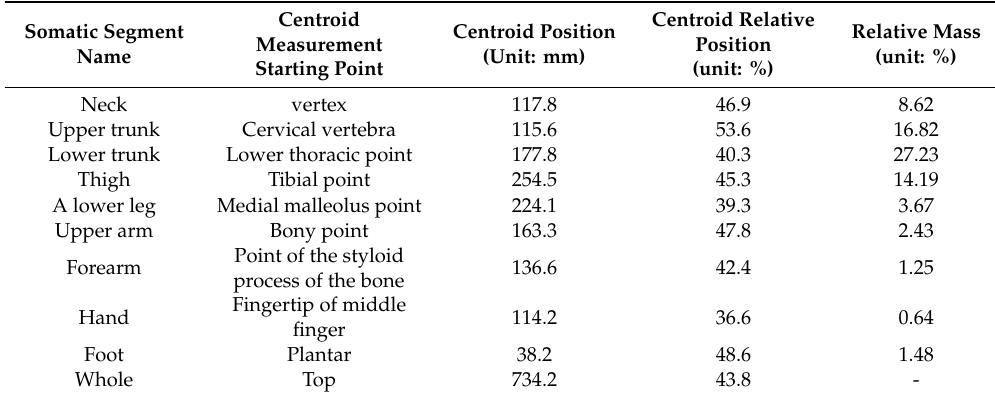
Table 1. Male part data in adult human body inertia